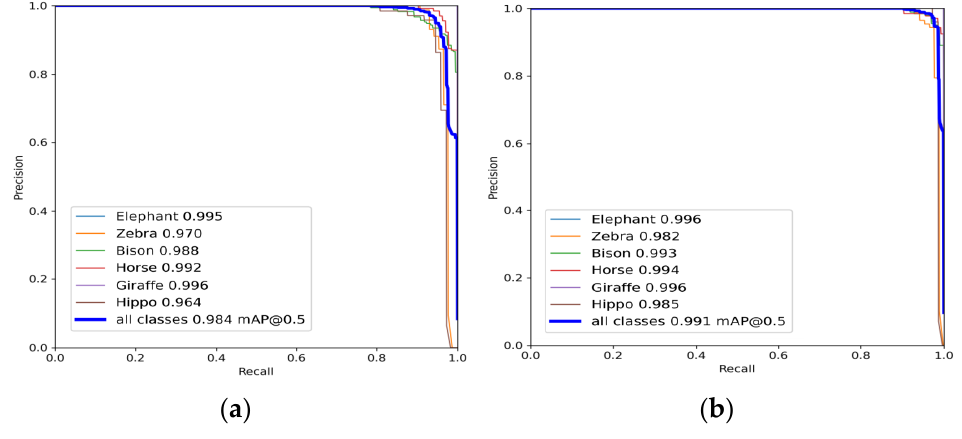
Figure 7. ( a ) YOLOv5s PR curve; ( b ) improved YOLOv5s PR curve.